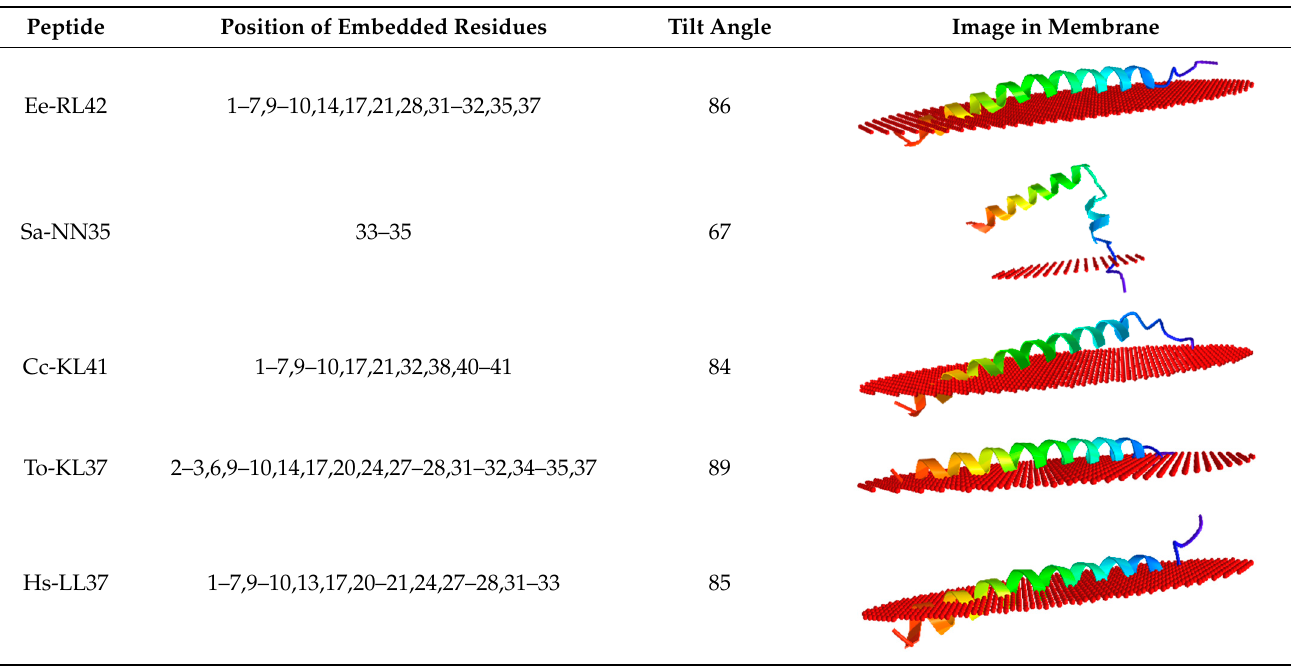
Table 3. Models and parameters obtained from the server Orientation of Proteins in Membranes (https://opm.phar.umich.edu/ accessed on 9 May 2022). A computational approach for optimizing the spatial arrangement of protein structures in lipid bilayers.